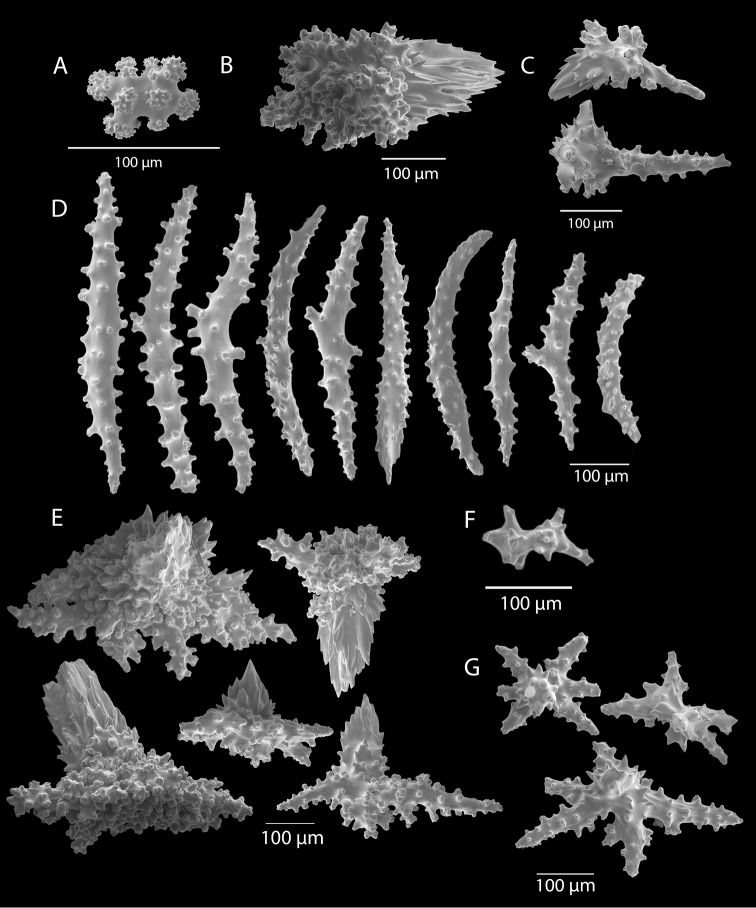
Placogorgia species A. SBMNH 422970, SEM image. A Small capstan form B Chunky torch-type spindle C Crutch-type spindles D Long spindles E Thorn scales typical of the genus F Small, developing thorn scale, dorsal view G More developed thorn scales, dorsal view.